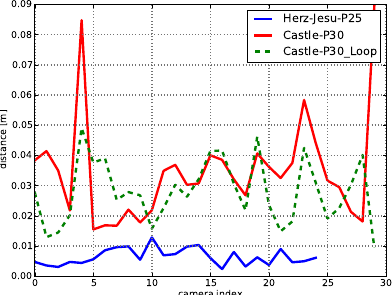
Figure 6: Distance error from Herz-Jesu-P25 and Castle-P30 with and without loop closure.